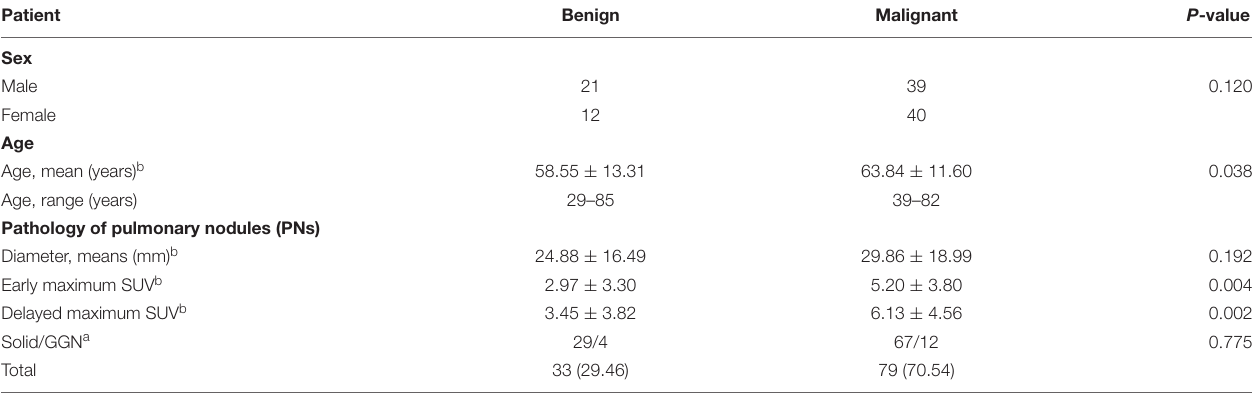
TABLE 1 | Patient characteristics.